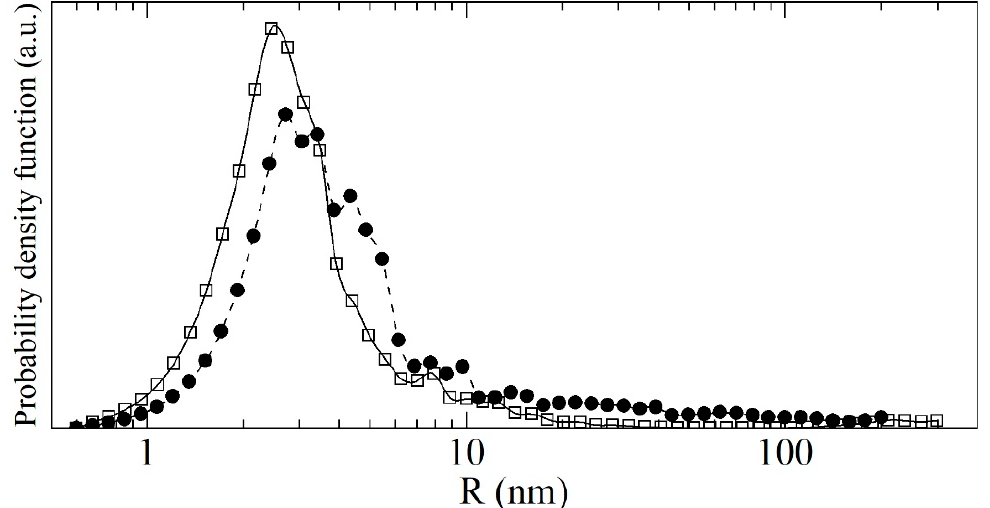
Figure 9. The log-linear volume distribution of scatterers evaluated using the discrete-sized diamond nanospheres model for the F-DNDs (solid circles) and DF-DNDs (open squares). Solid (DF-DNDs) and dashed (F-DNDs) lines interpolate the calculated results.